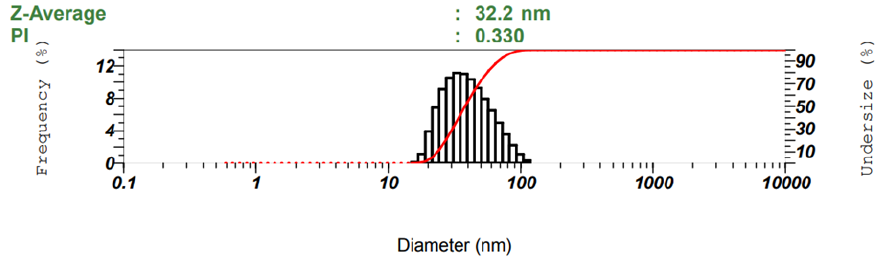
Figure 7. The results of particle size distribution of CPAM by DLS (CPAM was synthesized by conditions including stirring speed: 2600 rpm, temperature: 61 ◦ C, and reaction time: 7